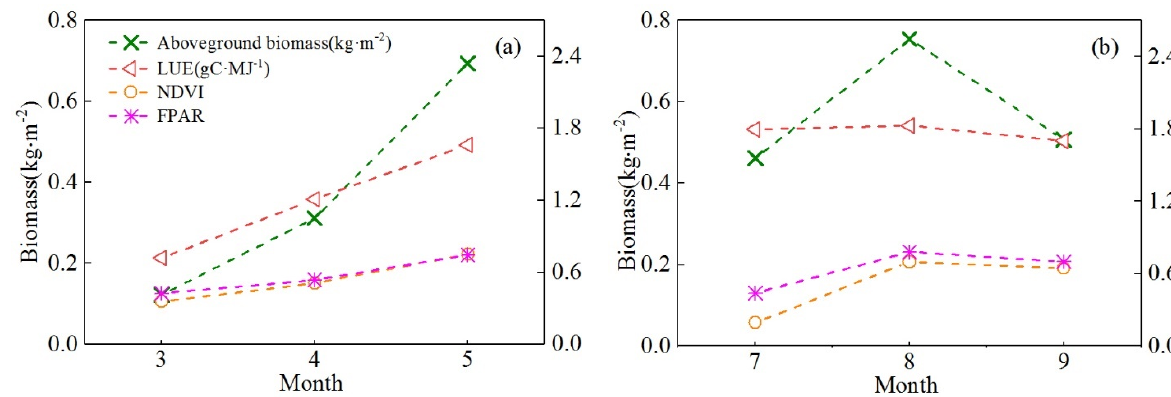
Figure 12. Seasonal variations in NDVI, FPAR, LUE, and biomass in the main growing seasons. ( a , b ) Variations in the biophysical parameters of winter wheat and maize, respectively.